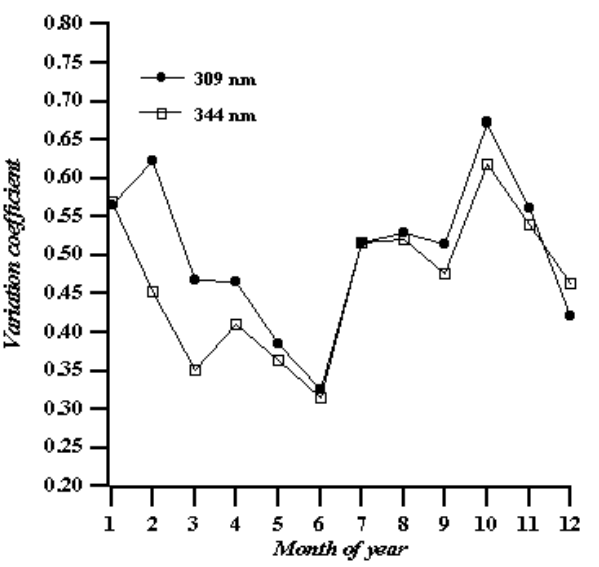
Fig. 5. The variation coefficients of the recorded UVR for the 309 and 344nm wavelengths for the whole period of